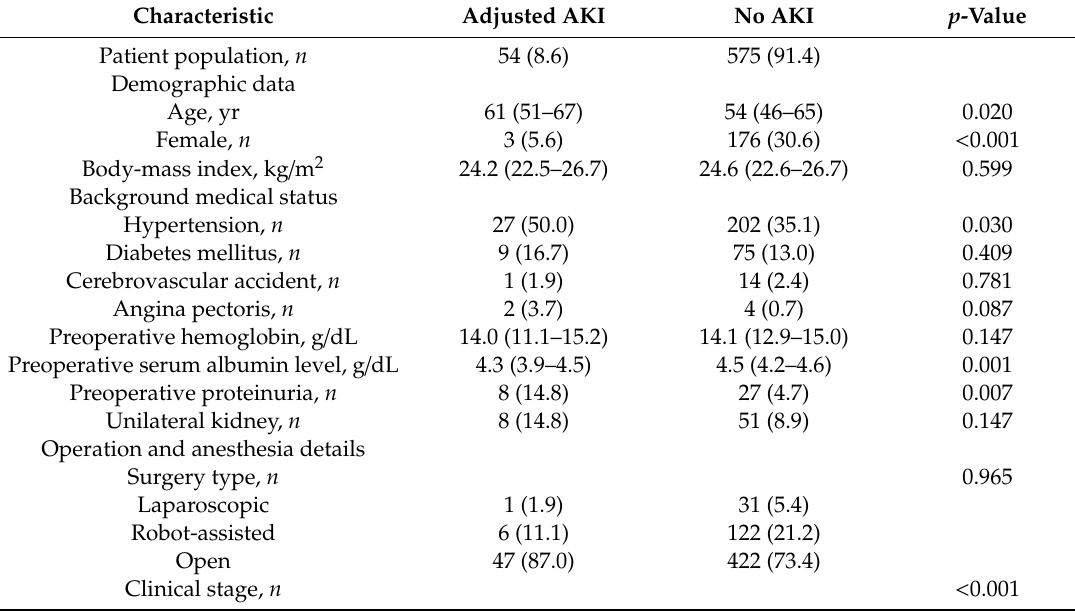
Table 1. Patient characteristics and perioperative parameters according to acute kidney injury adjusted for parenchymal mass